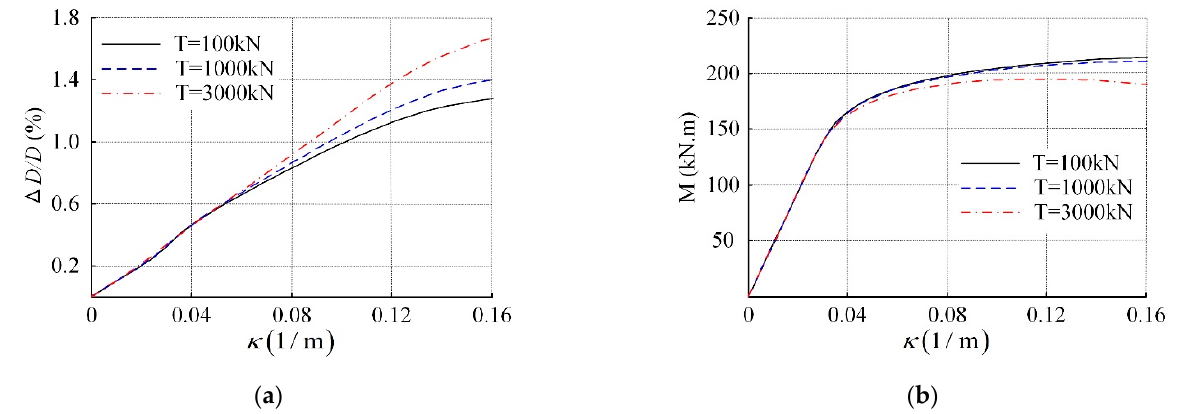
Figure 18. Effect of axial tension on ovalization and bending moment during pipe reeling: ( a ) variation of ovalization with curvature, ( b ) variation of bending moment with curvature.